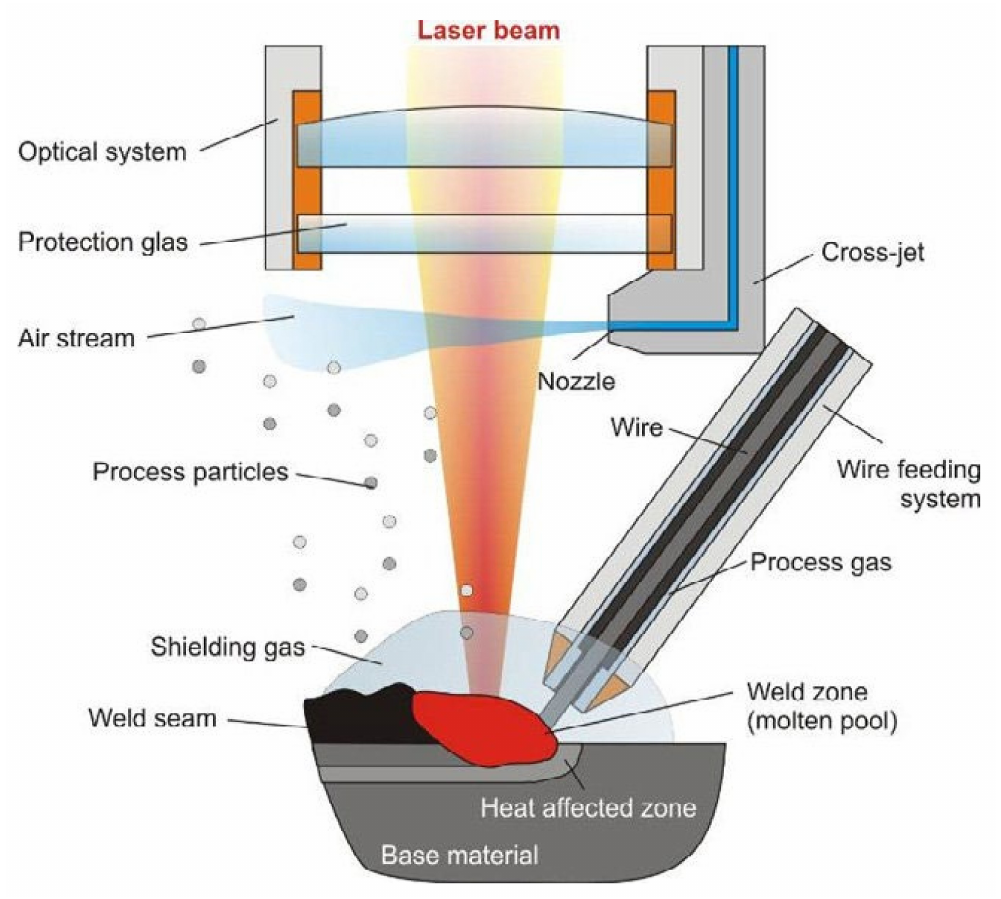
Figure 10. Schematic of laser cladding operation. Image adapted from